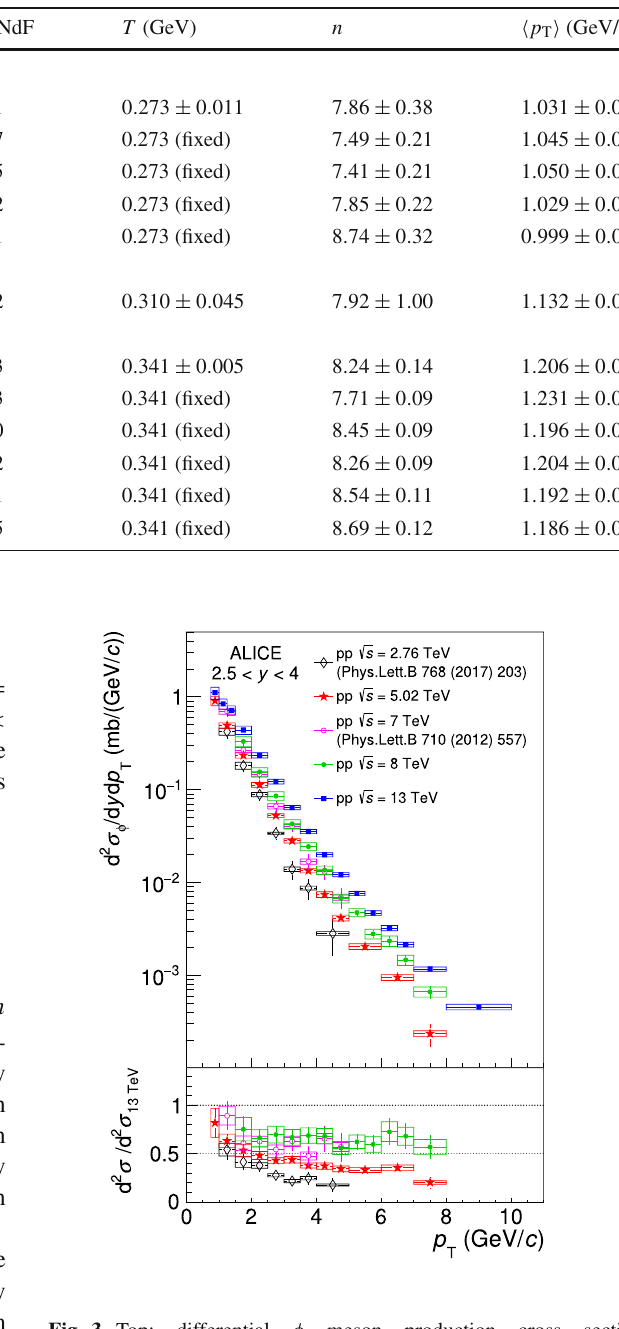
Fig. 3 Top: differential φ meson production cross section √ s = 2.76, 5.02, 7, 8 and d 2 σ/( d y d p T ) as a function of p T at 13 TeV. The boxes represent the systematic uncertainties, the error bars the statistical uncertainties. Bottom: ratio between the cross sections √ s = 13 TeV measured at several energies to the one obtained at √ s = 5 . 02 TeV, the lowest energy consid- more evident at